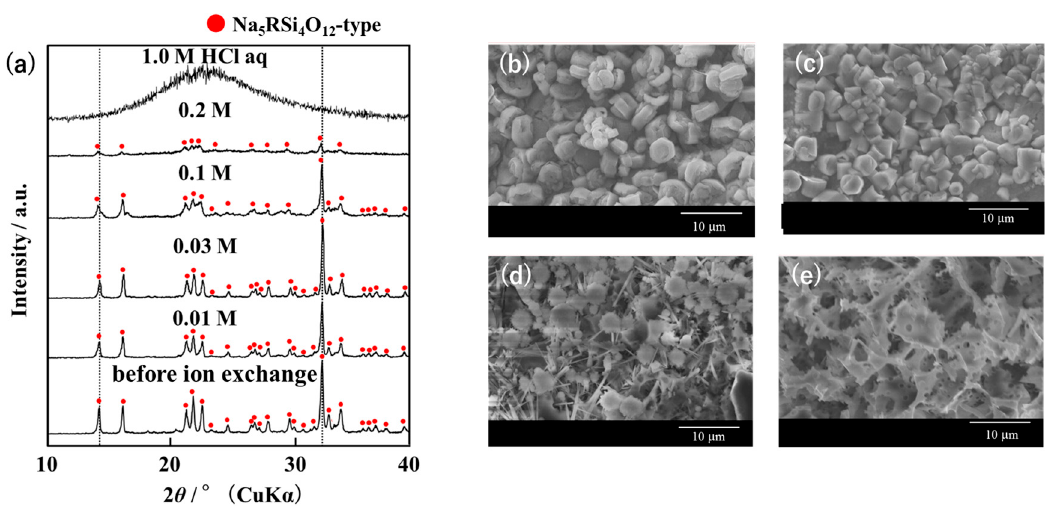
Figure 4. XRD patterns ( a ); SEM photographs of starting ( b ); ion exchanged Narpsio glass-ceramics in 0.03 M ( c ); 0.1 M ( d ); 1.0 M HCl aqueous solutions ( e ). The red solid circles in Figure 4a